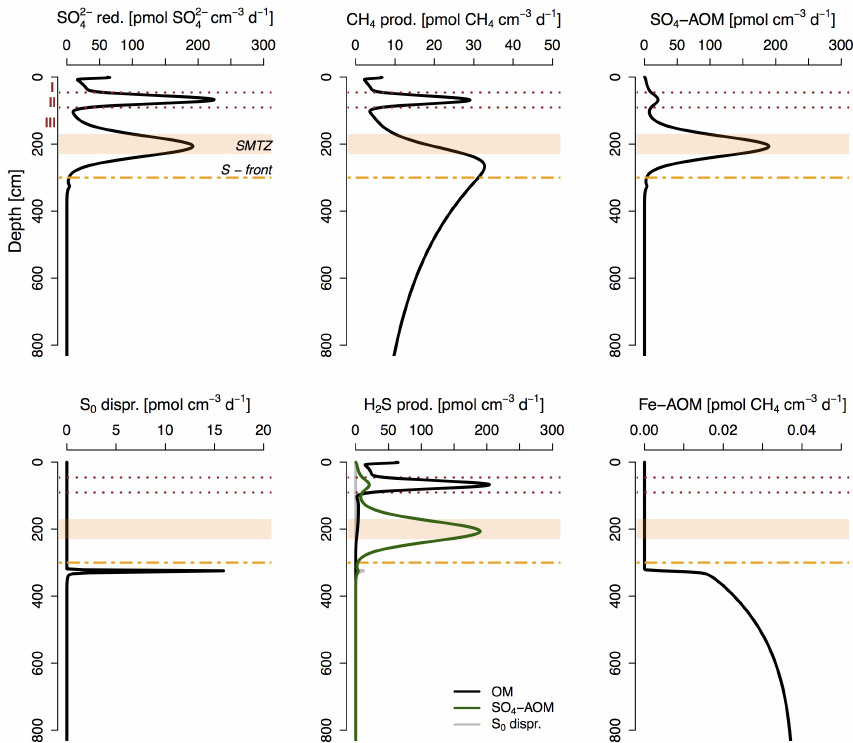
Figure 6. Modeled rates of total SO 2 − reduction, total CH 4 production, SO 4 -AOM, S 0 disproportionation, sulfide production and Fe-AOM. 4 Red dotted lines and roman numbers indicate the transitions between the lithological Unit I (modern coccolith ooze), Unit II (marine sapropel) and Unit III (limnic deposits). The orange bar represents the sulfate-methane transition zone (SMTZ), and the orange dashed line shows the current position of the downward-migrating sulfidization front (S front).